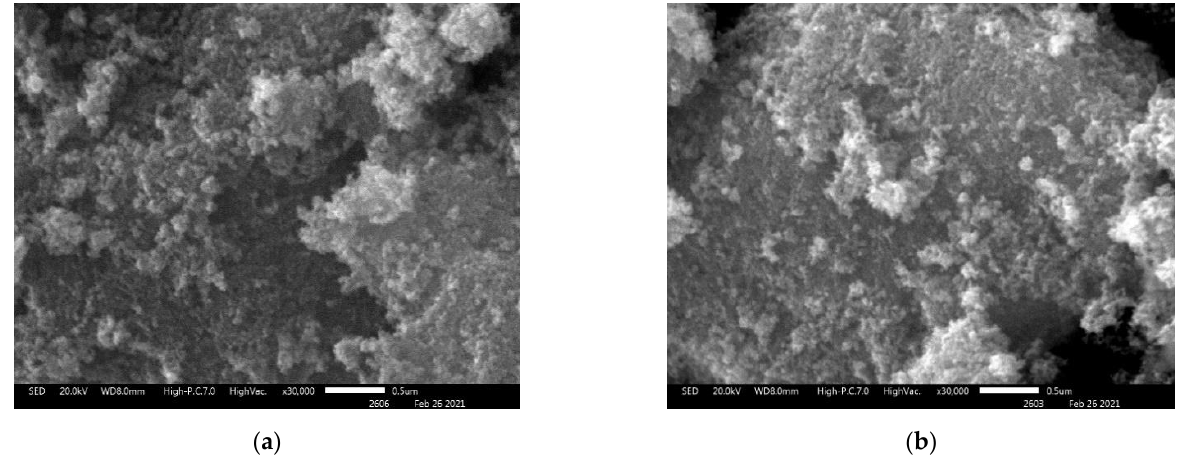
Figure 7. Scanning electron microscopy (SEM) images of ZnO NPs ( a ) and ZnO NPs modified by BDP ( b ), ×30,000. The composition and structure of the composites based on BC were studied by IR spectral analysis, atomic absorption spectrophotometry, and complexometric titration of zinc oxide (Table 6, Figure S4).